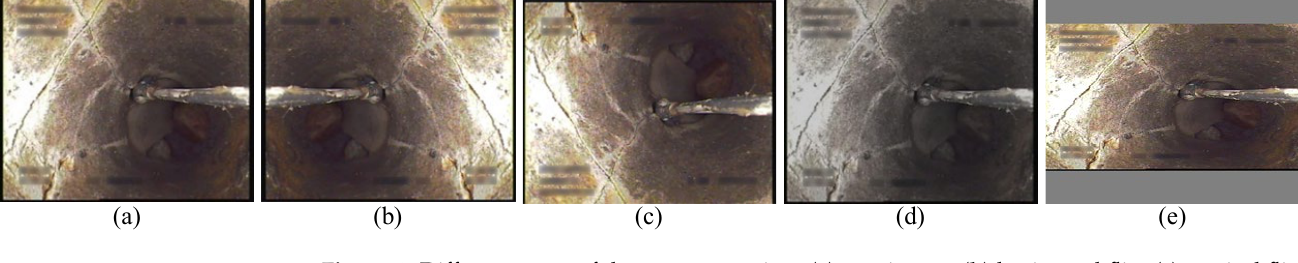
Figure 6. Structure of the CSP_ResBlock_Body module. 3.3.2. The Improved YOLOv4 Model Although YOLOv4 applies many improved strategies based on YOLOv3, it does not perform well when directly applied to the sewer defect detection task, and there will be missed and wrong detections in some defect types. To address these issues, this paper proposed an improved model based on YOLOv4. The original YOLOv4 network feeds the last feature layer P3 of the backbone network into the SPP module for feature enhancement. This module has many advantages, such as the ability to solve the target multiscale problem to some extent, obtaining different im- portant context features to expand the receptive field [3] , and not significantly slowing